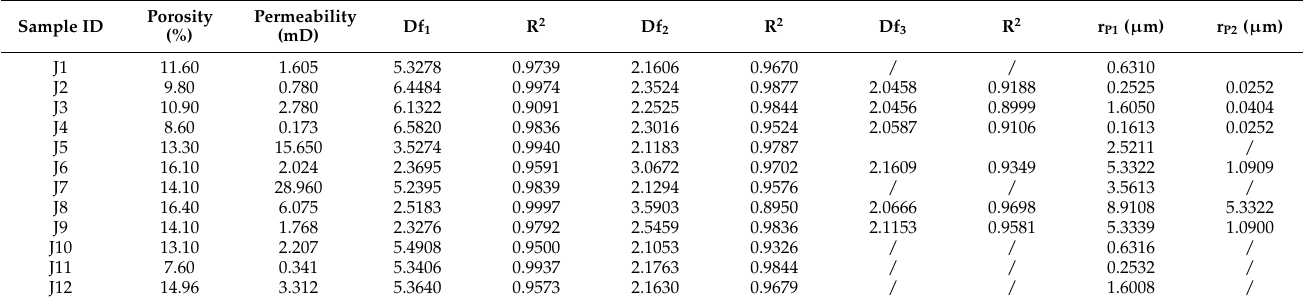
Table 5. Fractal dimension calculation of HPMI.